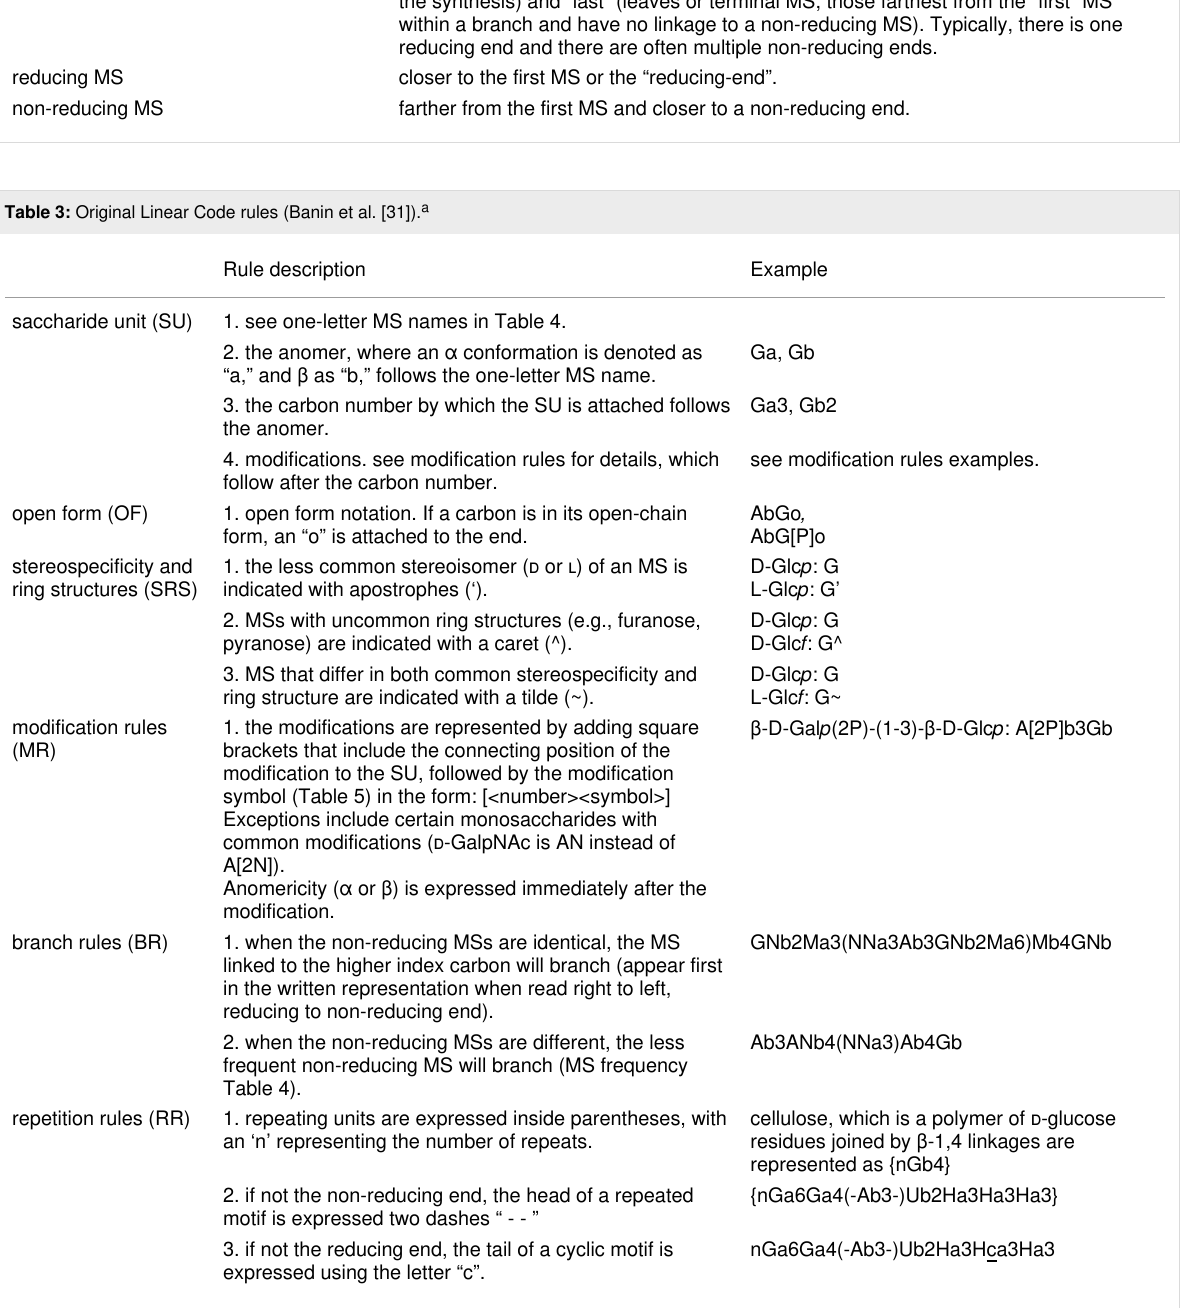
Table 3: Original Linear Code rules (Banin et al. [31]). a